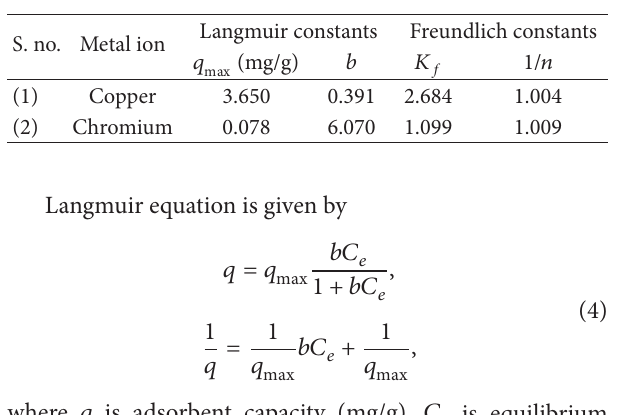
T 1: Langmuir and Freundlich constants for copper and chromium adsorption using